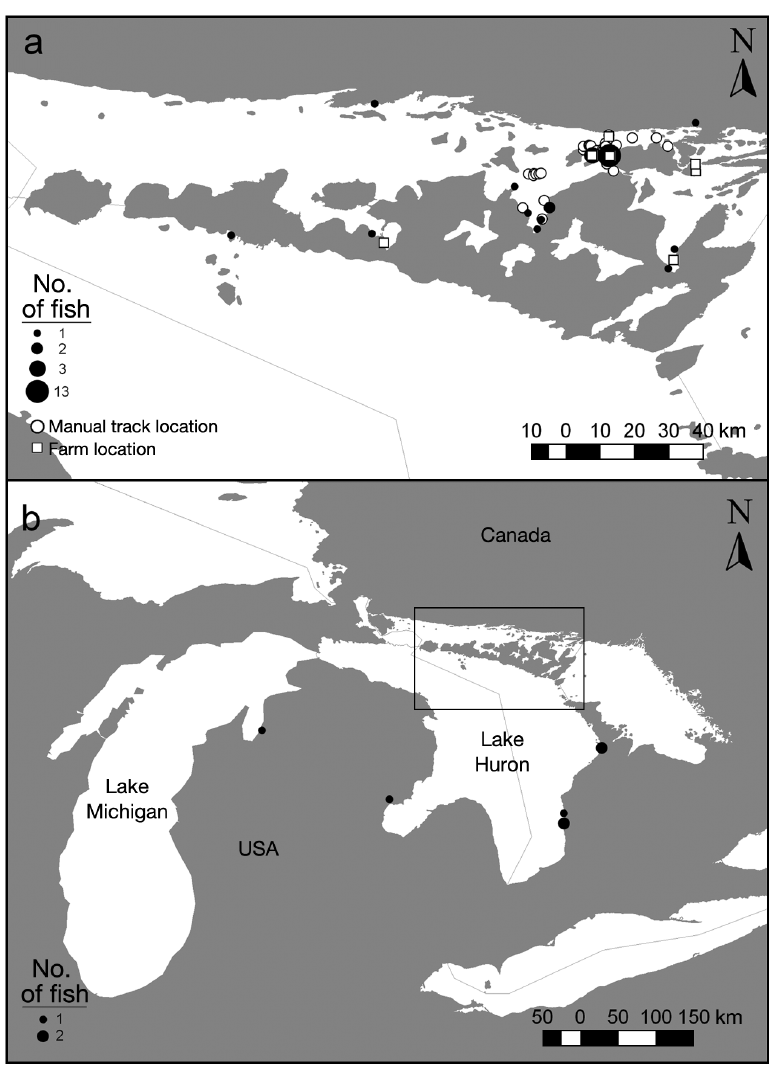
Fig. 5. Oncorhynchus mykiss . Locations of telemetry- (open circles) and Floy- tagged (solid circles) rainbow trout released from Farm 1. Open squares indi- cate farm locations. The number of escapees are represented by the size of the symbol for fish detected or captured (a) in the Manitoulin Island region and (b) the extent of the range over which Floy-tagged fish were caught, including the south end of Lake Huron and Lake